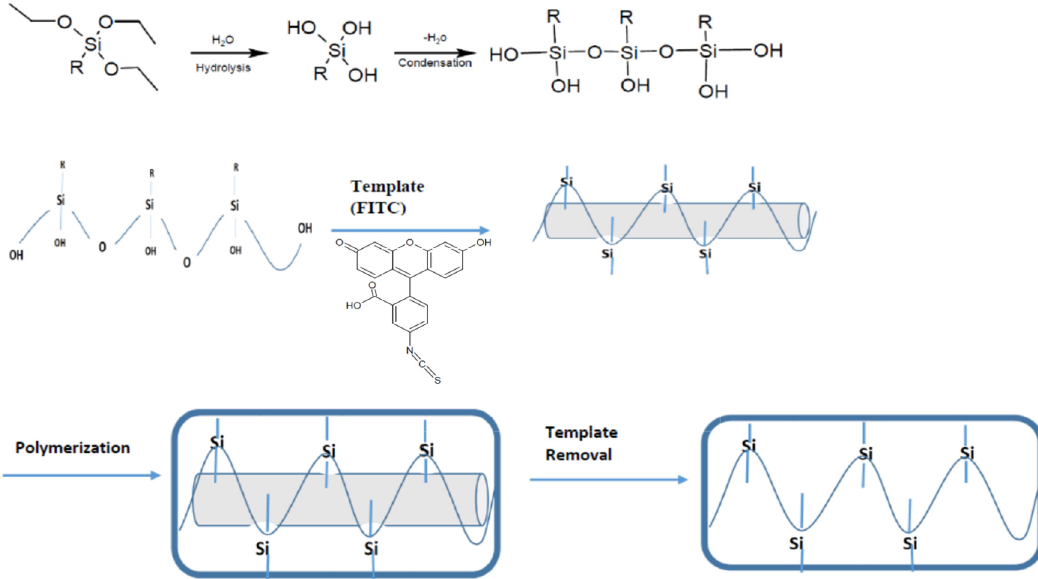
Figure 3. Molecularly Imprinting Technique using inorganic silanes as polymer precursors, and FITC as the template molecule. The silane precursors polymerize through hydrolysis and condensation reactions to form a three-dimensional, interconnected polymer network around the template.